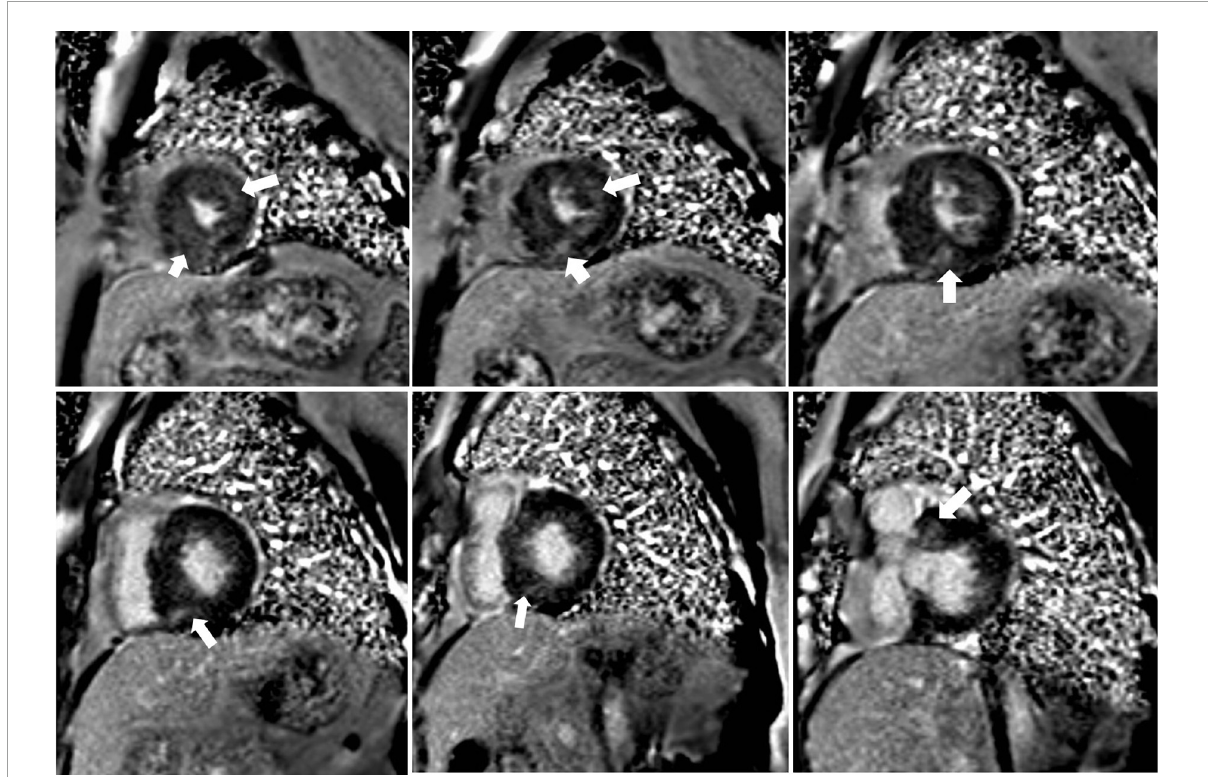
FIGURE1 Representative short-axis late gadolinium enhancement (LGE) images in a 35-year-old male with obstructive hypertrophic cardiomyopathy showing diffuse hyperenhancement (white arrows) in the ventricular septum with 11.3% LGE compared to the LV mass.